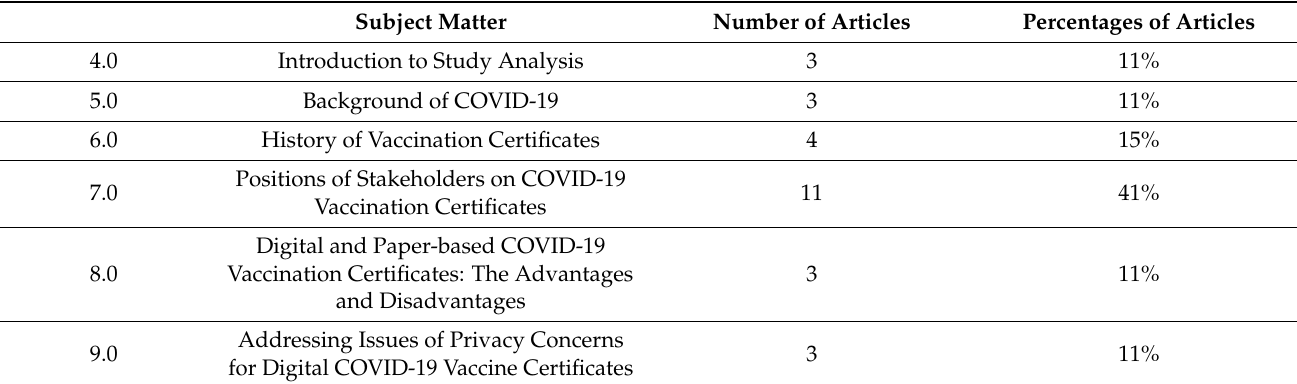
Table 3. Results of Included